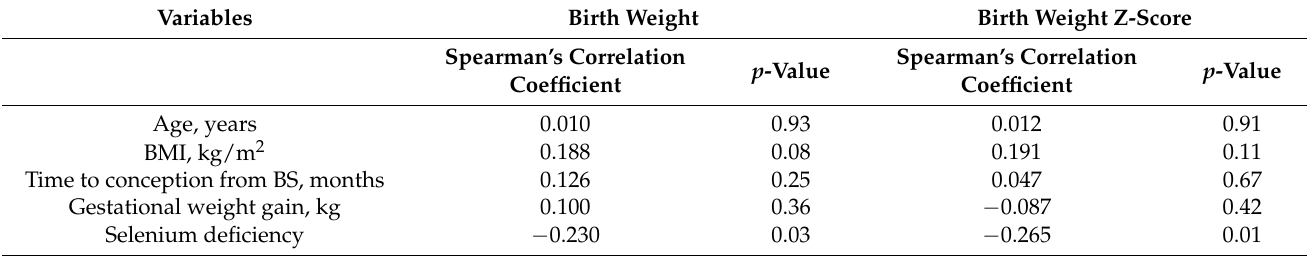
Table 3. Characteristics that were correlated with birth weight and with birth weight z-score using Spearman’s correlation test. Variables Birth Weight Birth Weight